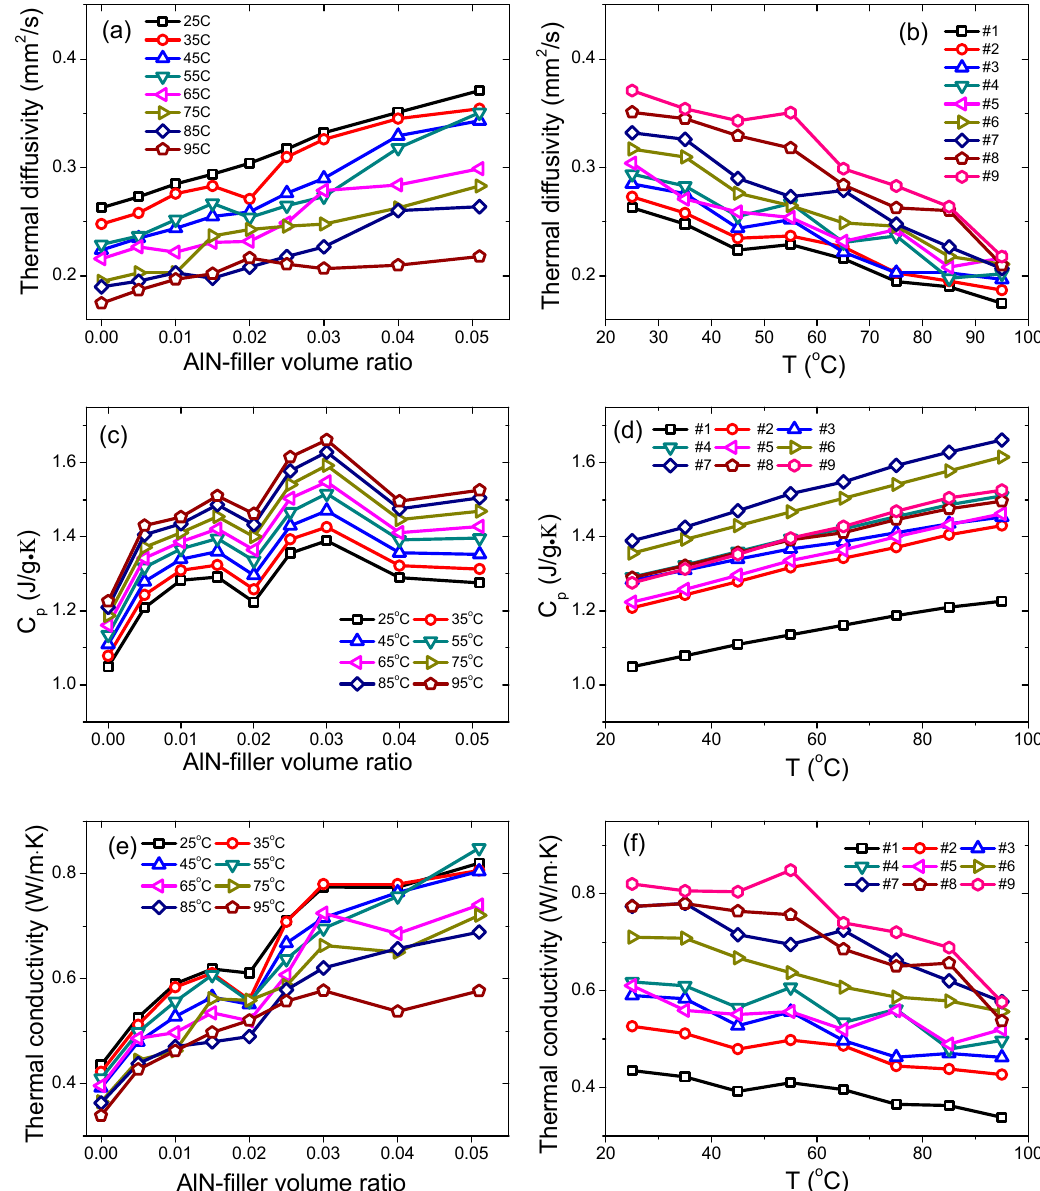
Figure 9. Temperature-dependent ( a , b ) thermal diffusivity, ( c , d ) heat capacity, and ( e , f ) thermal conductivity of the AlN-filled silicon rubber composites.